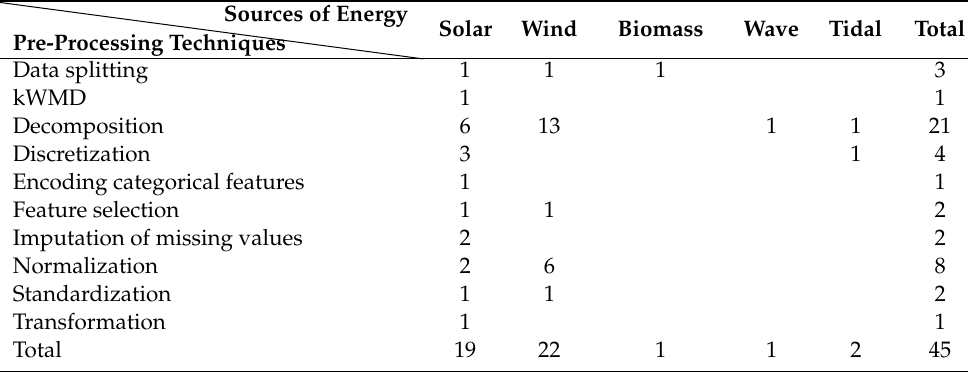
Table 4. Pre-processing techniques used by machine-learning models in renewable-energy predictions with various renewable energy sources.